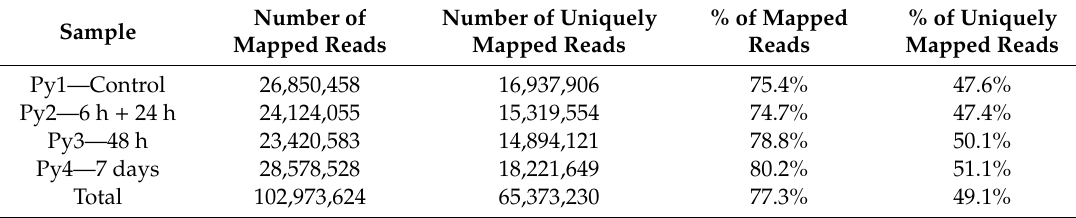
Table 2. Mapping statistics for each sequenced library. Number and percentage of mapped and unique mapped reads.